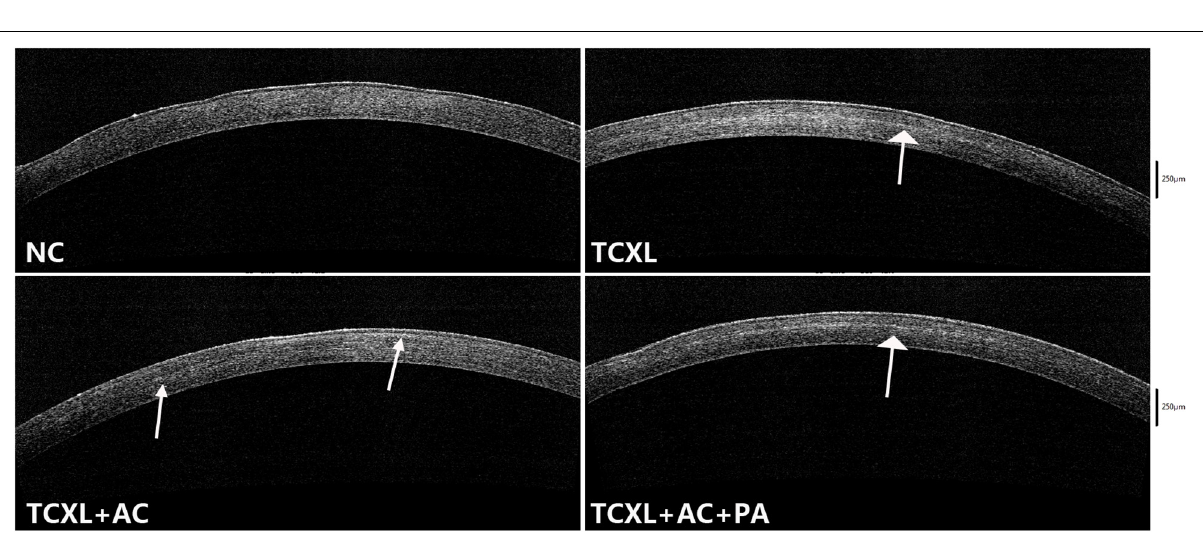
FIGURE 4 | Representative images of anterior segment optical coherence tomography showing the demarcation line (white arrows) in the corneal stroma on D28. No demarcation line could be observed in the normal control. The demarcation lines in the TCXL and TCXL + AC + PA groups were distinct and homogeneous, but indistinct and blurred in the TCXL + AC